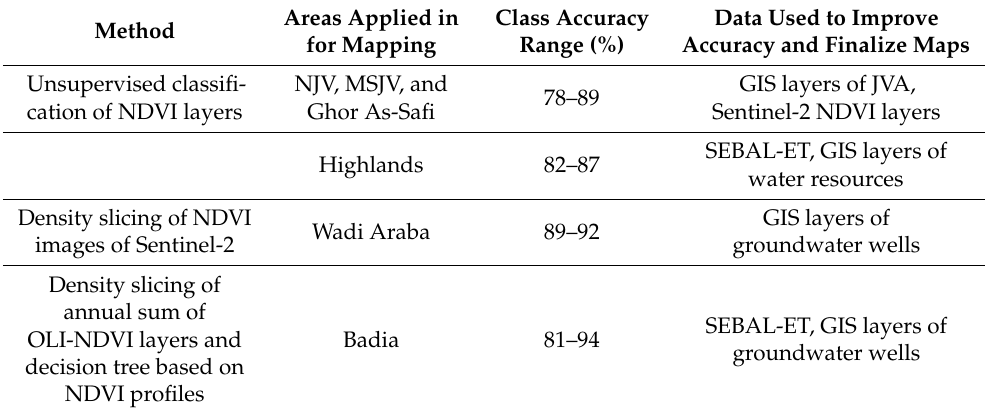
Table 1. Summary of digital classification methods and their accuracy.